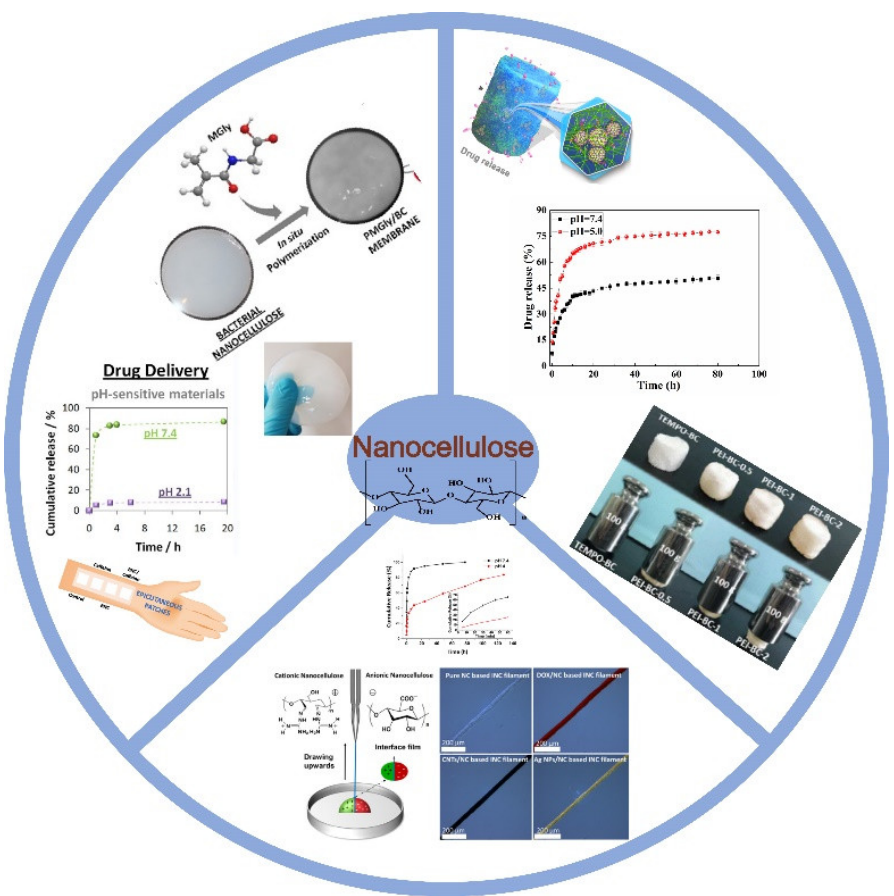
Figure 1. Schematic illustration of different nanocellulose-based materials used for drug delivery.